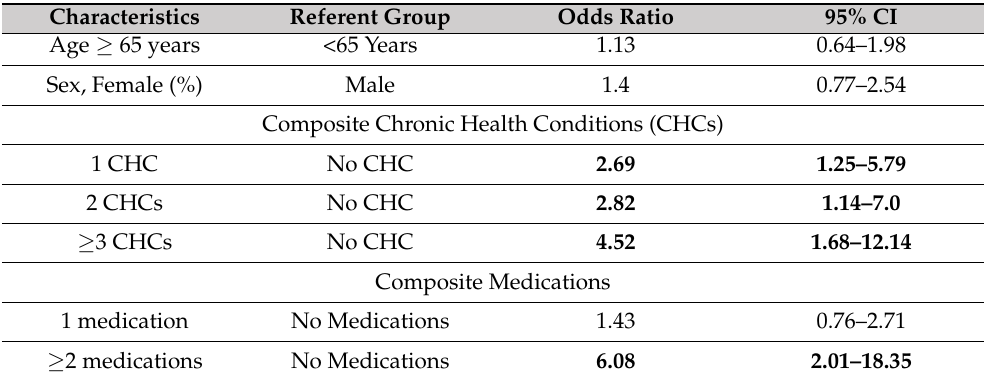
Table 2. Multivariable association between clinical characteristics and SARS-CoV-2 Spike IgG anti- body negative